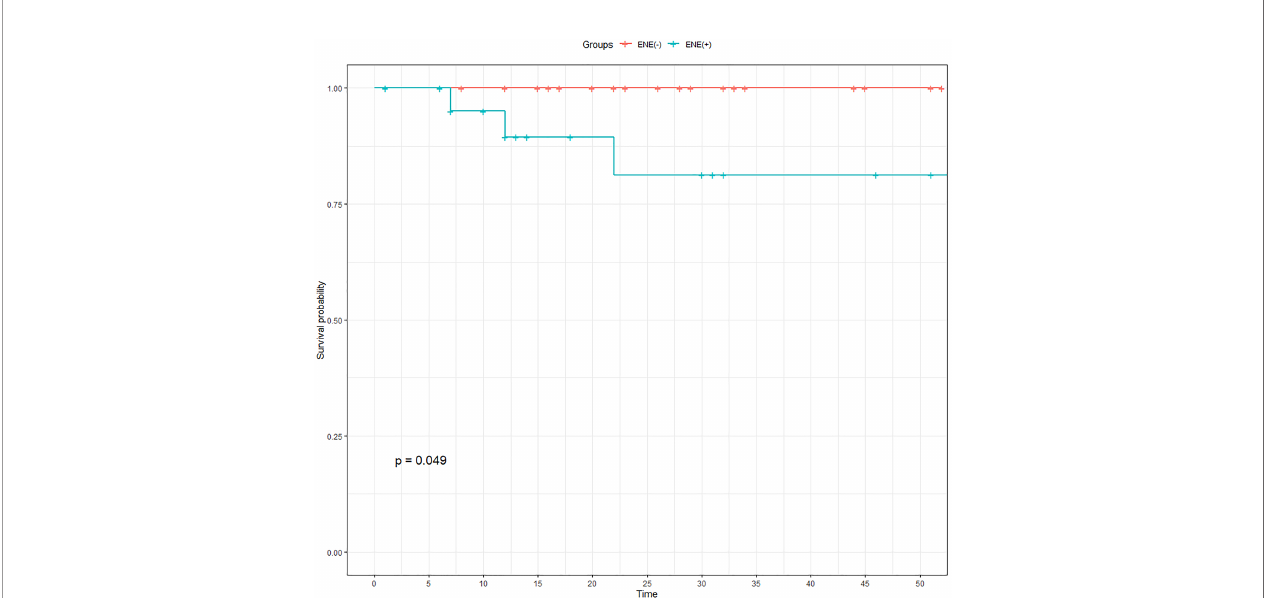
FIGURE 4 | Comparison of recurrence-free survival of PTC patients after propensity score matching. ENE, extranodal extension; PTC, papillary thyroid carcinoma.